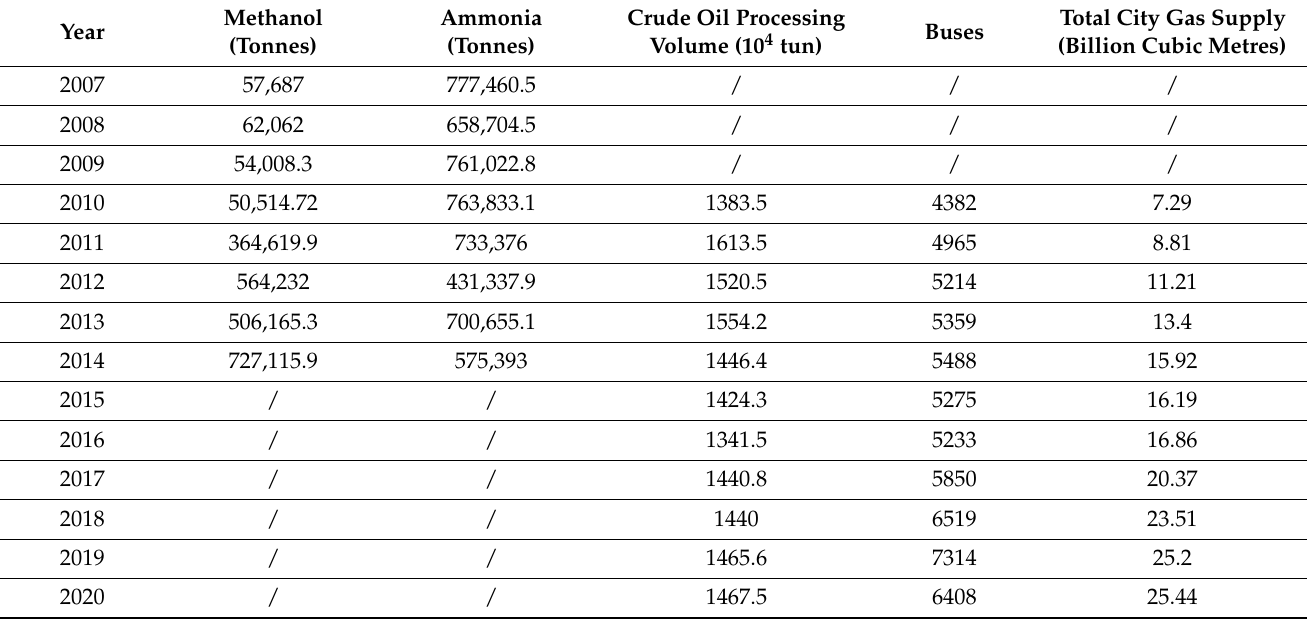
Table 2. Historical data on hydrogen loads in various